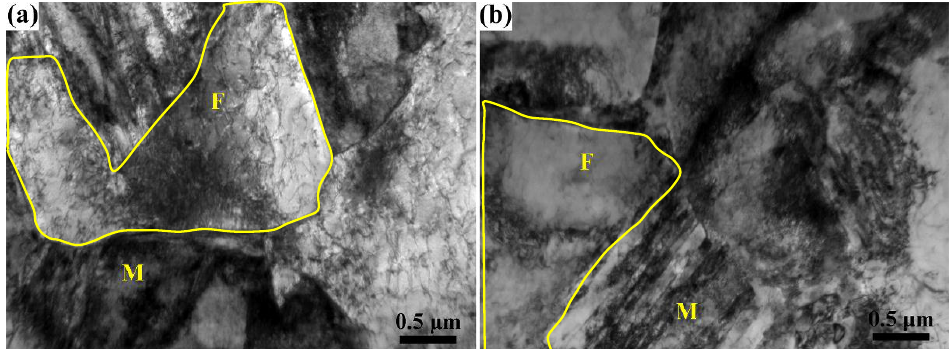
Figure 4. Representative TEM microstructures of specimens with ferrite and martensite quenched from 810 °C and tempered at ( a ) 180 °C and ( b ) 450 °C, respectively.